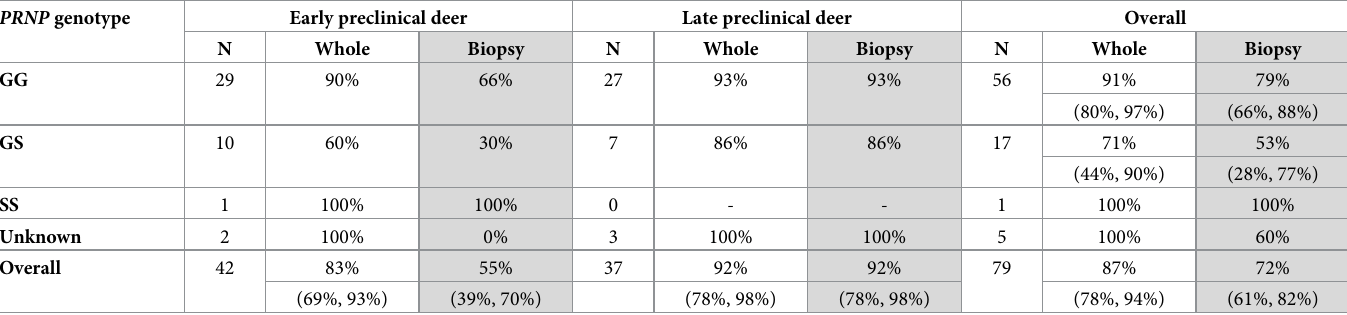
The total number (N) of deer and the diagnostic sensitivities of each sample type (whole tissue section versus biopsy) are indicated at each intersection of infection stage (columns) and genotype at PRNP codon 96 (rows). The 95% confidence intervals for the ‘overall’ estimates are indicated